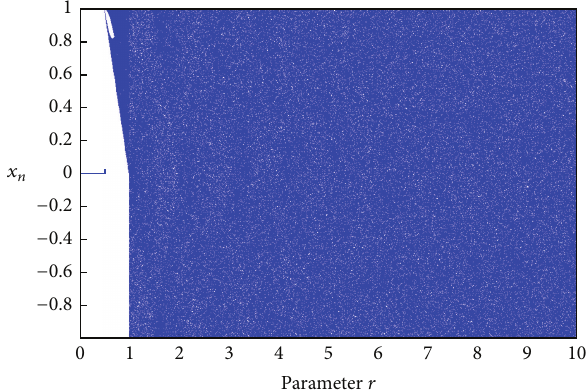
Figure 3: The sensibility of the 𝑓 𝑟 map to changes of the control parameter 𝑟 .